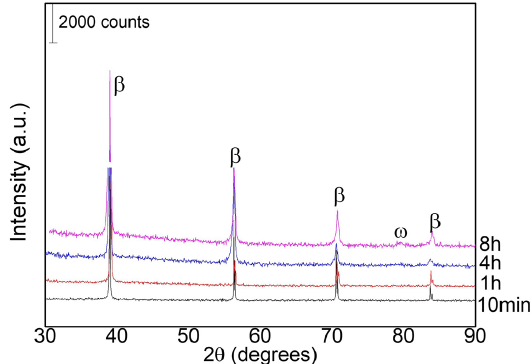
Figure 5. XRD patterns of each of the aged samples heated to 400 ºC at a heating rate of 1 ºC/min for 10 min, 1 h, 4 h, and 8